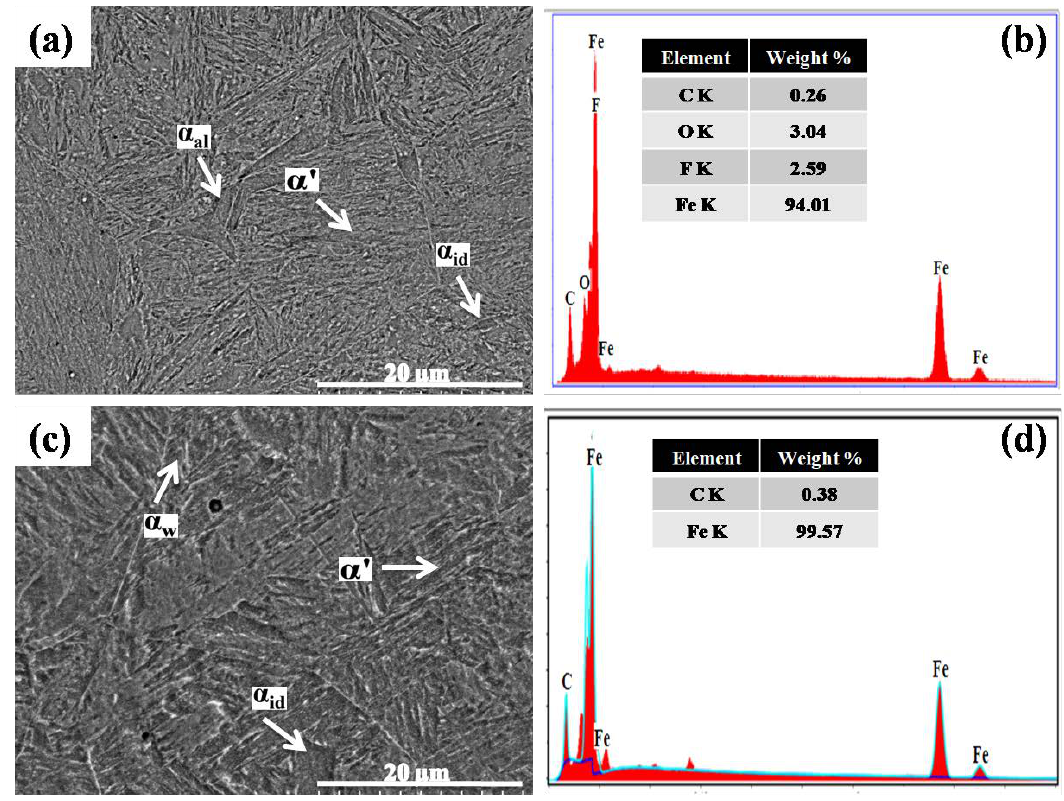
Figure 2. SEM images and EDS spectra of ( a and b ) water quench-hardened and tempered and ( c and d ) brine (10 wt% NaCl) quench-hardened and tempered low-carbon steel.